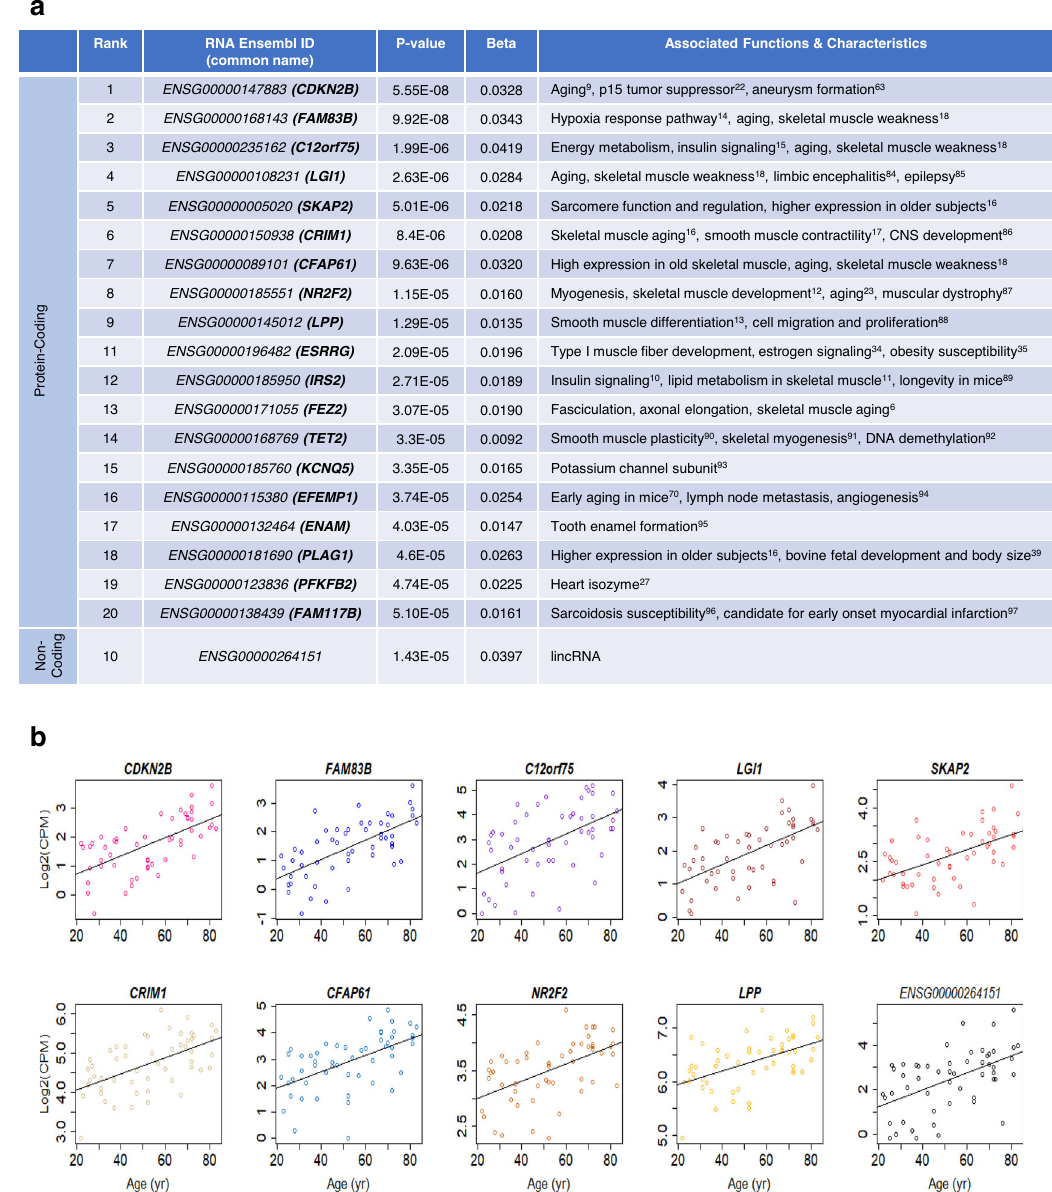
Fig. 2 Top 20 signi fi cant ( p < 0.01) RNAs (ENSGs) identi fi ed by linear regression with positive β - values for age. a Linear model p -values (two-sided Wald test, unadjusted) and β - values, and RNA characteristics obtained from literature review, are shown. RNAs that failed to have at least ten samples with CPM values above − 3 were removed. b Linear plots representing log2(CPM) values with age for the top ten RNAs ranked by the lowest p -value (two-sided Wald test, unadjusted) 36,37,84 – 96